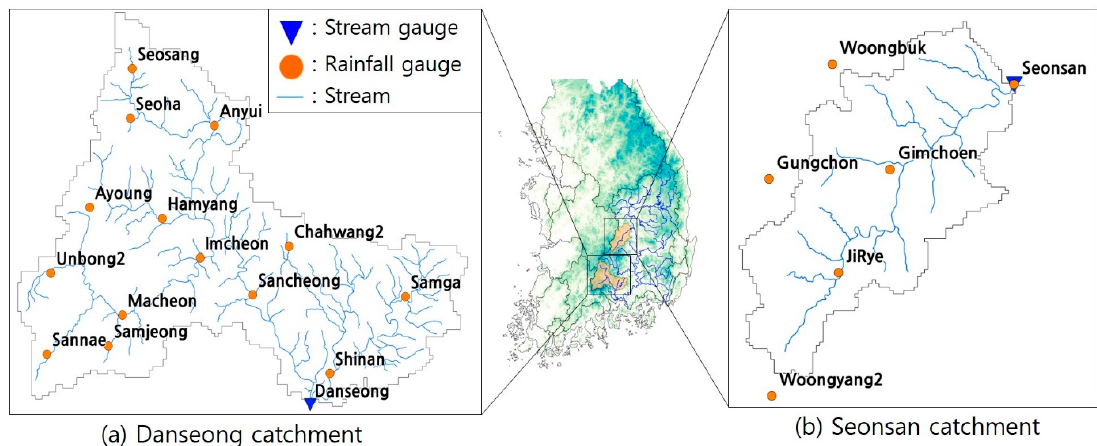
Figure 2. Distribution of catchments, water levels, and rainfall stations.